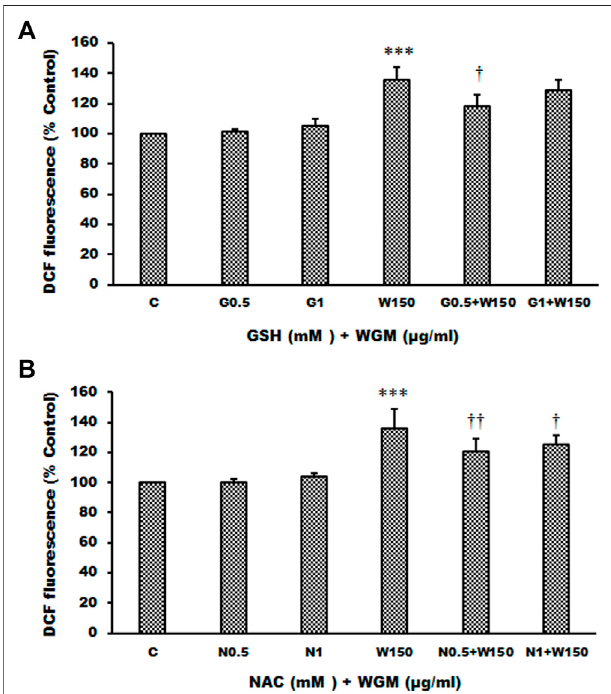
FIGURE 9 | Effects of GSH or NAC on WGM extracts-induced ROS production of Hep3B cells. (A) Cells were pretreated with 0.5 or 1 mM GSH (G0.5 and G1) for 1 h and then 150 μ g/ml WGM extracts (W150) for 2 h. (B) Cells were pretreated with 0.5 or 1 mM NAC (N0.5 and N1) for 1 h and then 150 μ g/ml WGM extracts (W150) for 2 h. After treatment, cells were loaded with 5 μ M CM-H 2 DCFDA for 30 min. ROS fl uorescence was measuredusingamultiwellplatereaderatanexcitationwavelengthof485 nm and an emission wavelength of 538 nm. Data represent the mean percentage of control ±S.D. ( n = 4). *** p < 0.001 compared to the control values. † p < 0.05, †† p < 0.01 compared to the WGM extracts alone.